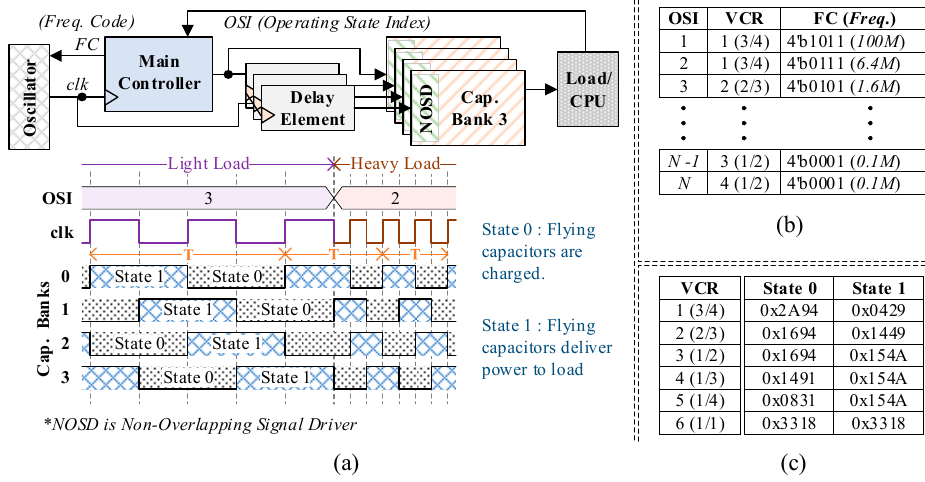
Figure 2. Proposed Switched Capacitor (SC) converter: ( a ) block diagram and operation; ( b ) an example Operating State Index (OSI) table in the controller; ( c ) Voltage Conversion Ratio (VCR) table specifying control signals for each